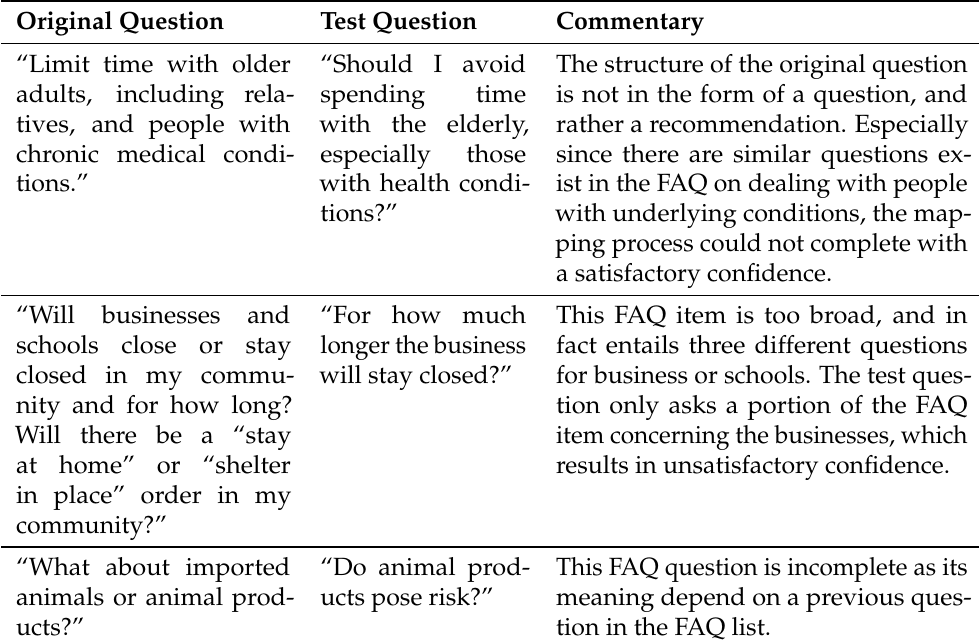
Table 2: Summary of unmapped